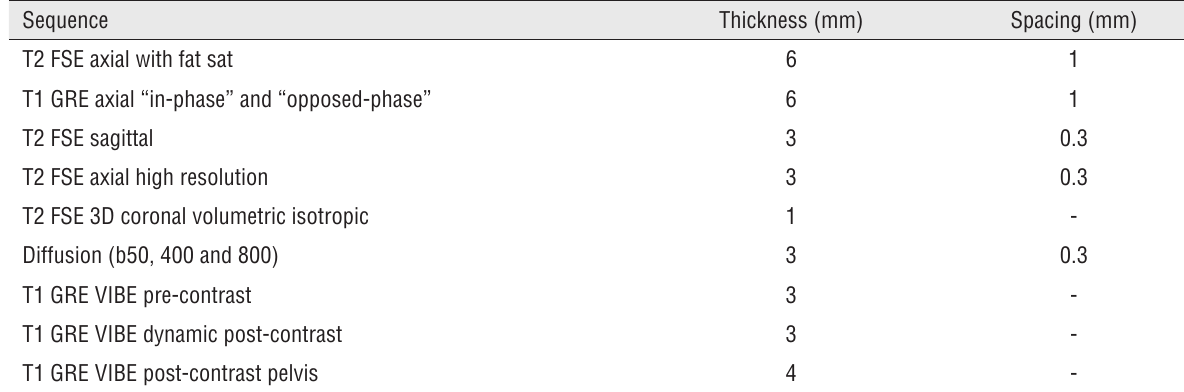
Table 1 - mpMRI prostate